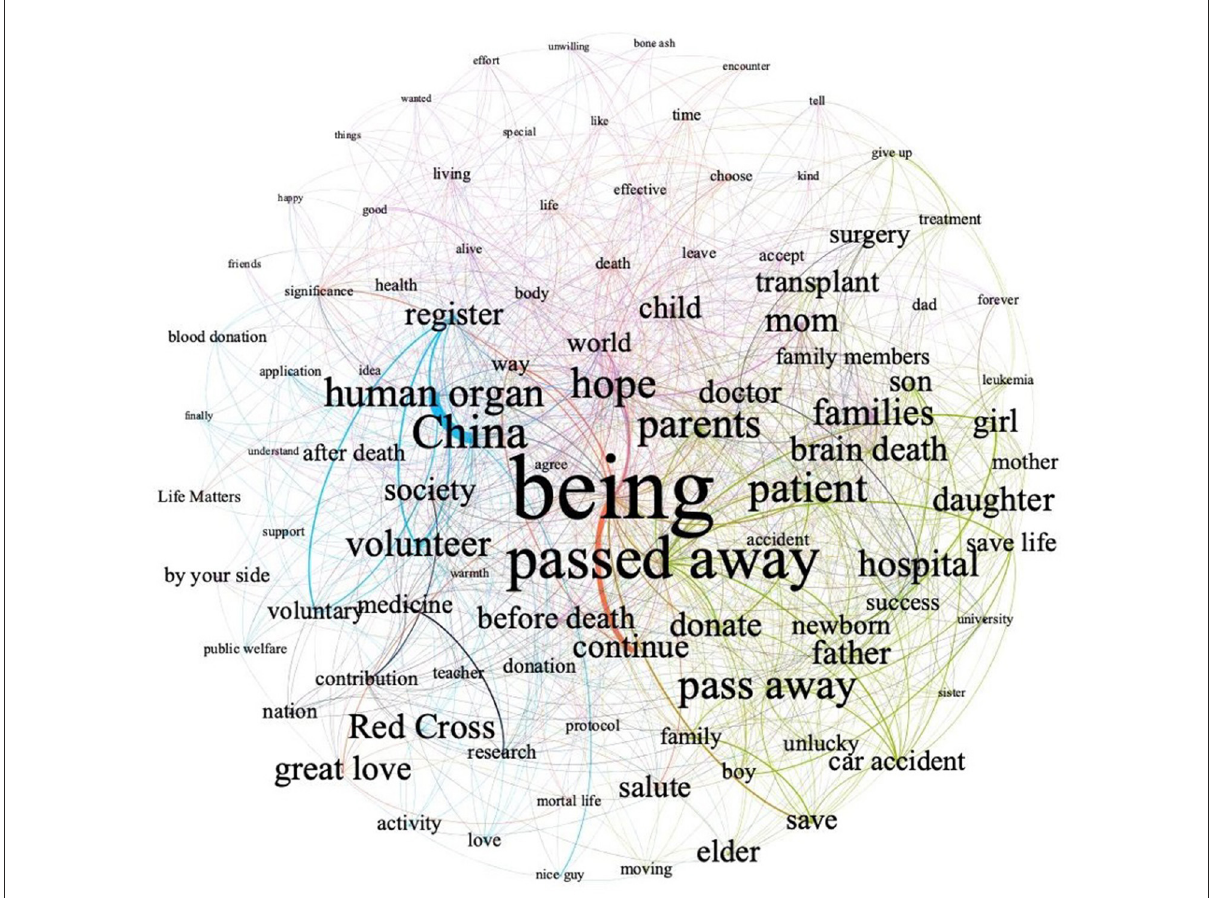
FIGURE2 Semantic network visualization regarding organ donation on